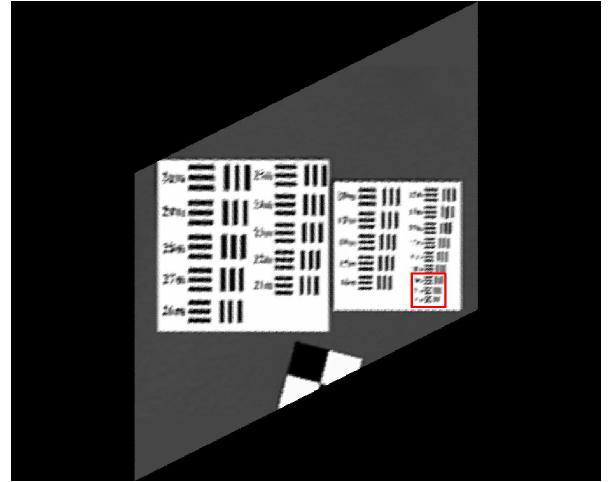
Figure 13. The target remote-sensing image experimental results: super-resolution images, the selected area is minimum resolvable line pairs.